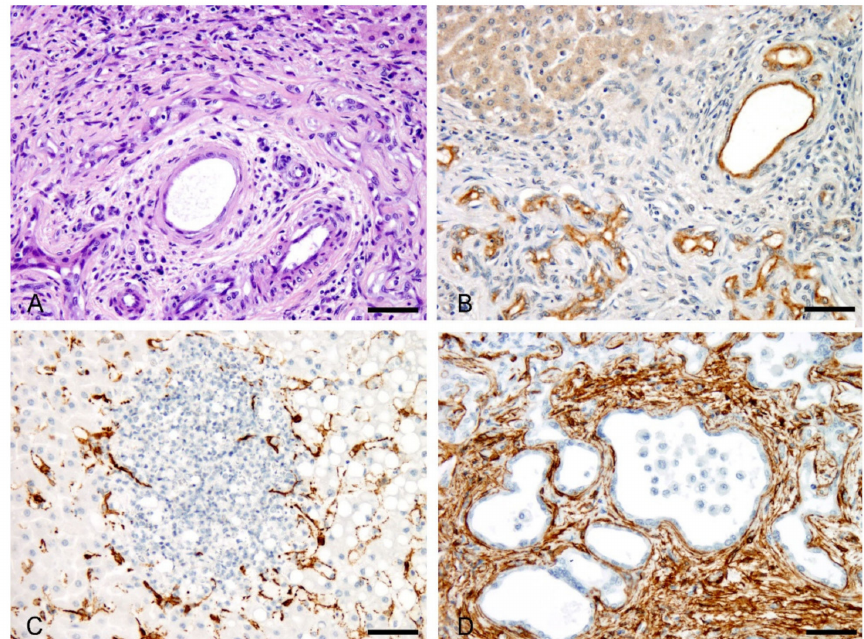
Figure 3. Immunohistochemistry in naturally acute and chronic acquired cases of FE in sheep. ( A ) Ectatic interlobular bile duct surrounded by a thin layer of collagen fibers (‘onion skin fibrosis’). lium, similar to showed in Figure 3A, and bile ductules. Bar, 50 µ m. ( C ) α -SMA-+ HSCs in areas of canalicular cholestasis in acute FE liver lesions. Bar, 50 µ m. ( D ) In chronic liver lesions observed in FE, α -SMA-+ HSCs cells accumulated and surrounded ectatic bile ducts. Bar, 50 µ